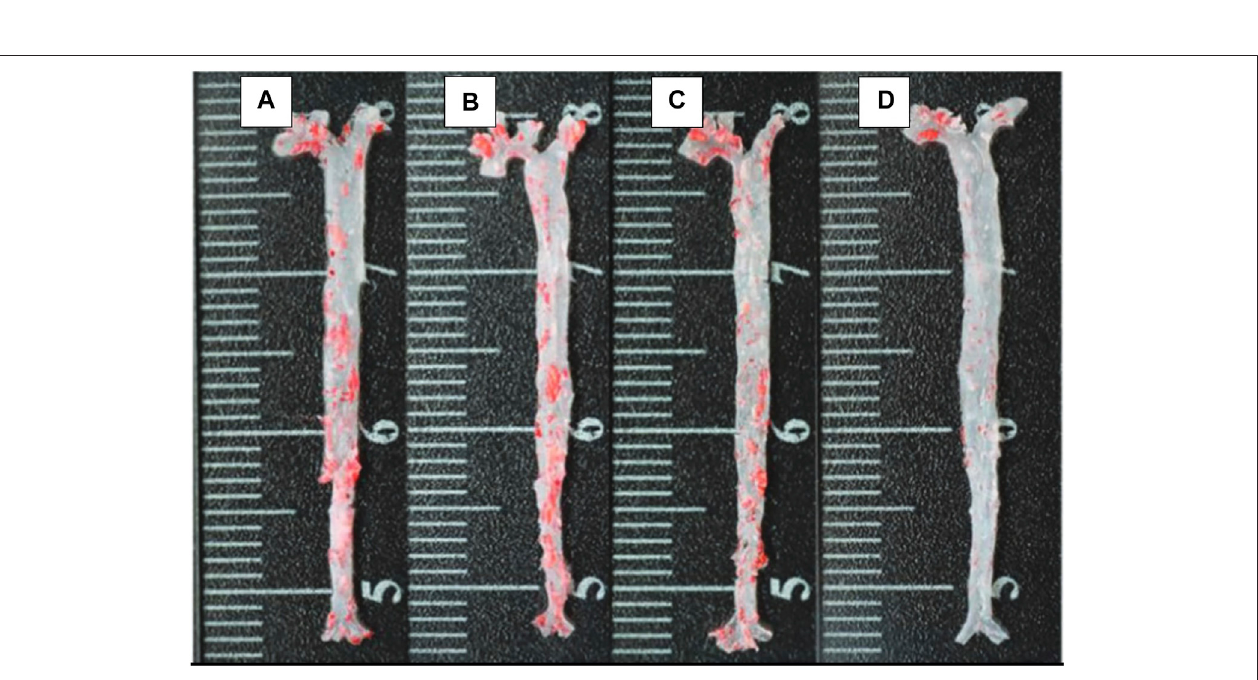
Frontiers in Chemistry |